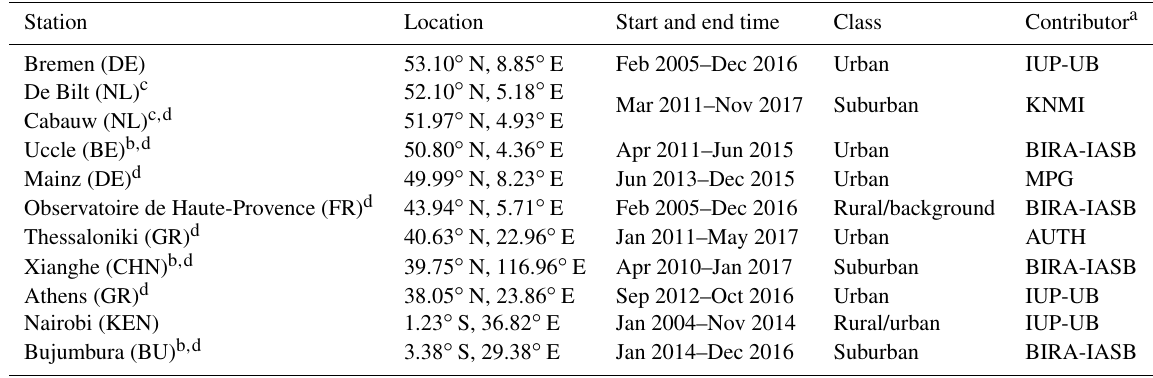
Table 2. Overview of contributing sources for the QA4ECV MAX-DOAS reference data set.